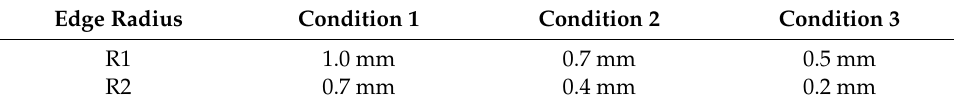
Table 2. Variables of simulation condition about edge radius of the punch and die.